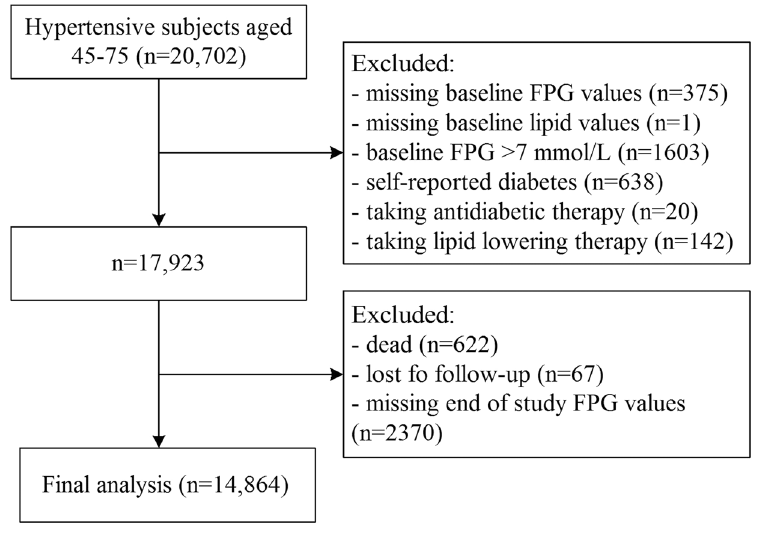
Figure 1. Subject